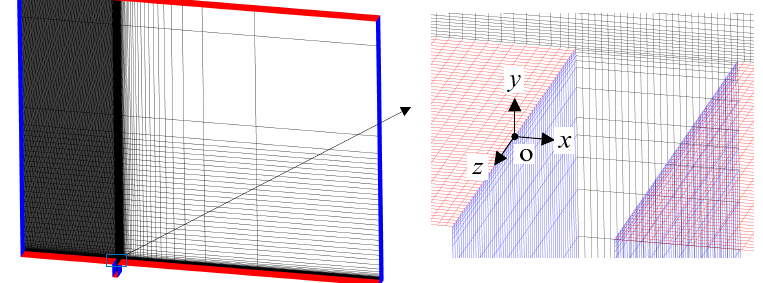
Figure 9. Computational grid, where every fourth grid line is shown for clarity.